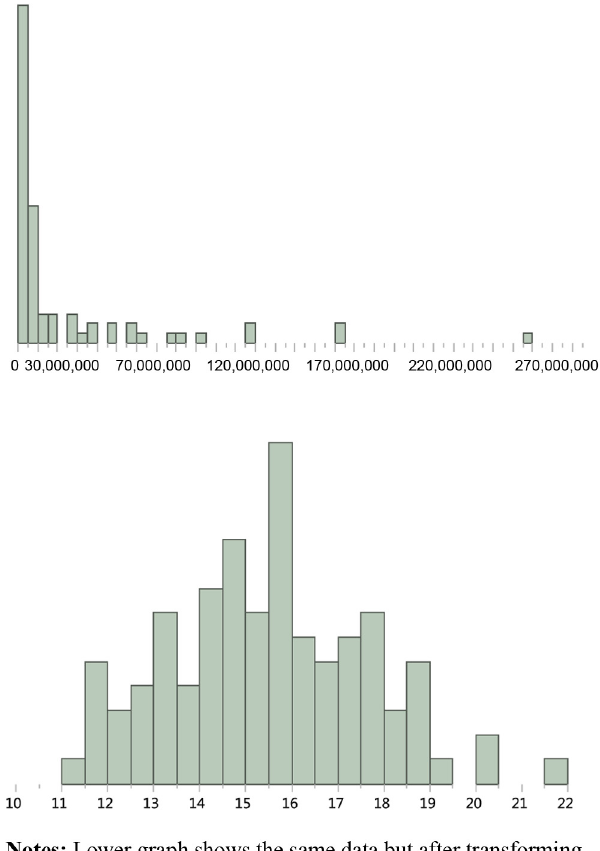
Figure 1. Upper graph